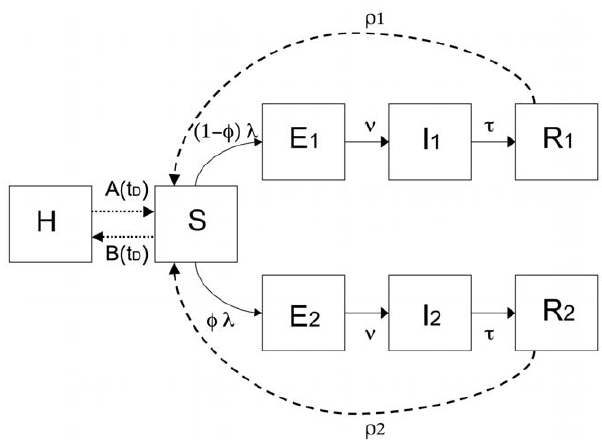
Figure 4. Compartment model for influenza. Each compartment correspond to a class of individuals in the population and arrows indicates transfer of individuals (table 1). In summary S stands for susceptible, E for exposed, I for infectious and R for recovery. The subscript 1 and 2 stands for mild and severe disease. The transfer of individuals from S to H is always 0 except for two scenarios where we assumed that persons after perceiving a higher number of deaths leave the community and become voluntarily isolated. Details on the model are given in the Methods. an exponential rate of decay in antibody titre in a way that, respectively, at the end of one or three years, 70% of individuals are still resistant to infection (table 1). The compartmental model is formalised by the following system of ordinary differential equations: